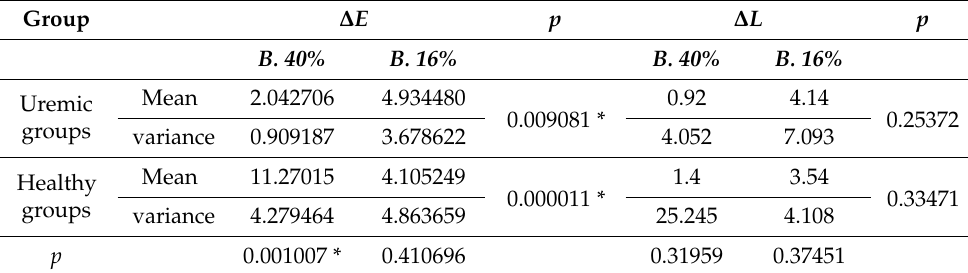
Table 1. Mean values, variance and statistical significance in ∆ E and ∆ L values between groups. Group ∆ E p ∆ L p B. 40% Mean Uremic groups Healthy groups